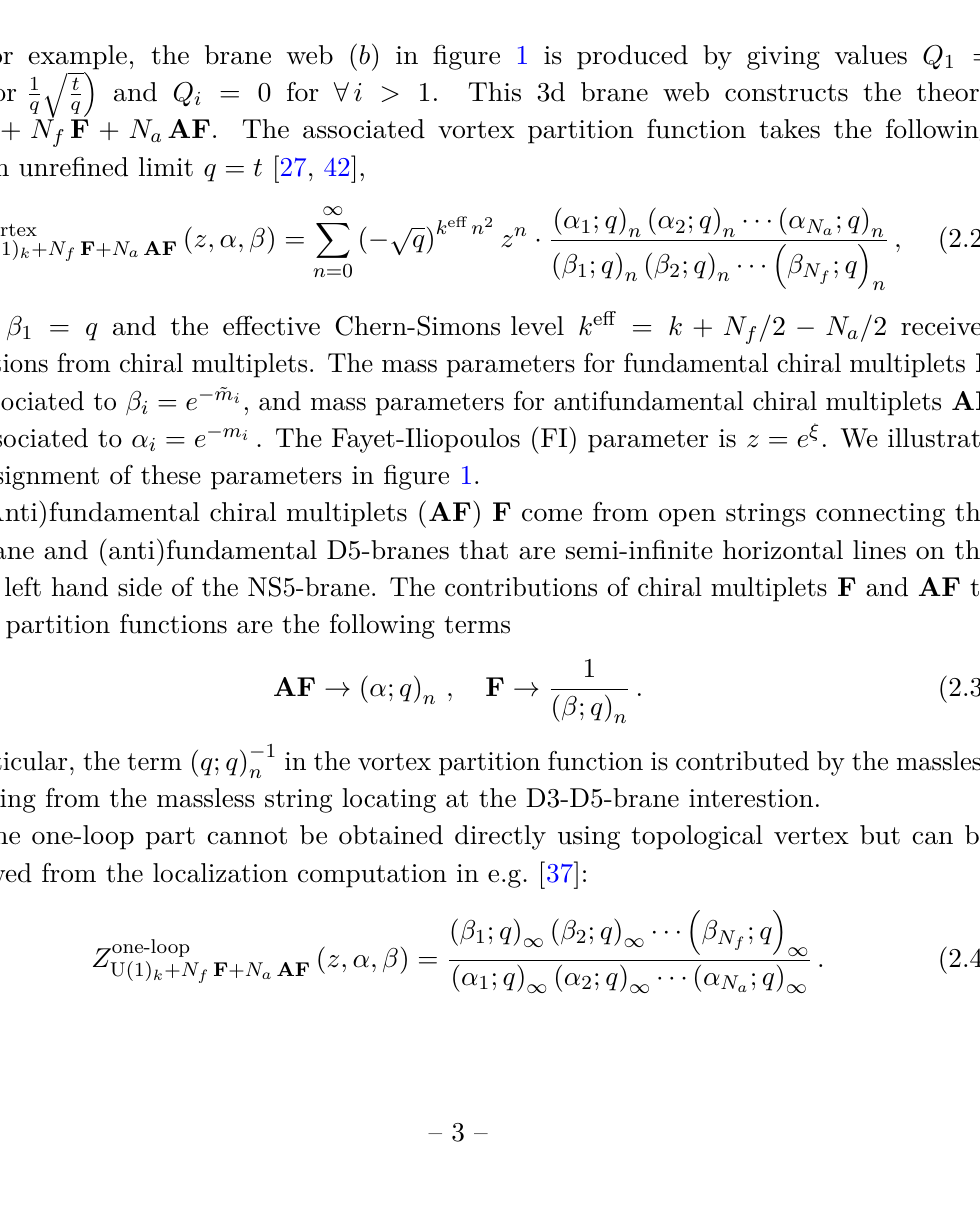
Figure 1 . In the diagram ( a ) , we show the Higgsing process. We prefer to create a D3-brane at the bottom line. After Higgsing local conifolds Q 1 , Q 2 , . . . , the NS5’-brane is lifted along the perpendicular direction and a D3-brane is created. The more precise 3d brane web is the diagram ( b ) , where the D3-brane is represented by a blue line. D5-branes and the NS5-brane are on the same plane, while D3-brane is perpendicular to this plane. Note that there could be a relative angle θ between the NS5-brane and the NS5’-brane. In the diagram ( b ) , we draw NS5-brane and NS5’-brane in parallel for